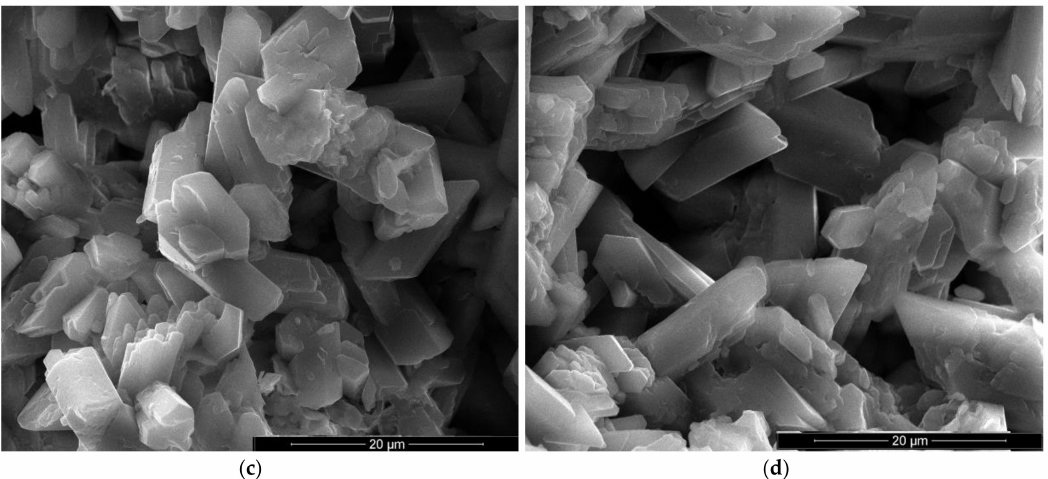
Figure 6. SEM images of gypsum plaster with 2% sodium bicarbonate addition (IB2) with various magnifications: ( a ) × 100; ( b ) × 500; ( c ) × 5000; ( d ) × 5000.